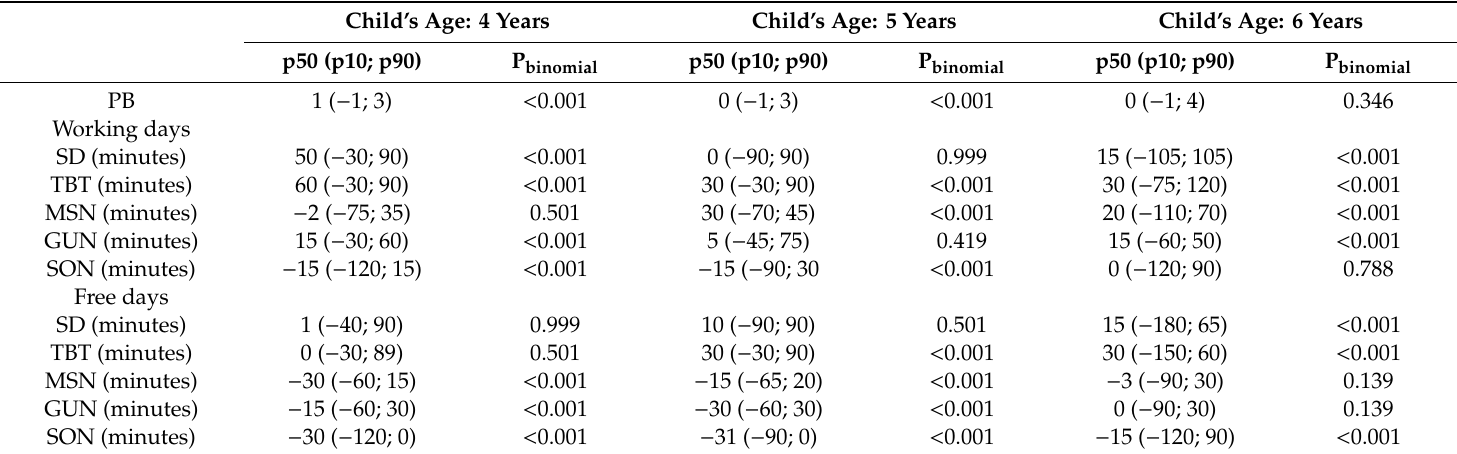
Table 2. Medians and 10th percentile–90th percentile ranges of women-men partner relationship score and sleeping di ff erences in 221 couples participating in the SPATZ